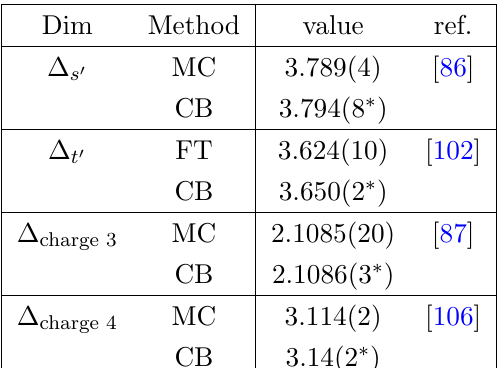
Table 4 . Comparison of conformal bootstrap (CB) estimates using the extremal functional method with previous Monte Carlo (MC) and (cid:15) -expansion (FT) determinations of operator dimensions. The values for the extremal functional determinations are means across the 40 di(cid:11)erent extremal spectra, and the errors are the standard deviations. We mark the errors with a (cid:3) to emphasize that they are non-rigorous. Here, \charge-3" and \charge-4" refer to the lowest-dimension scalars with the given charges, which in (cid:12)eld theory language are (cid:30) from the upper bound computations). The gaps we impose are the same as in the OPE scan discussed before, except that we set the twist gap (cid:14)